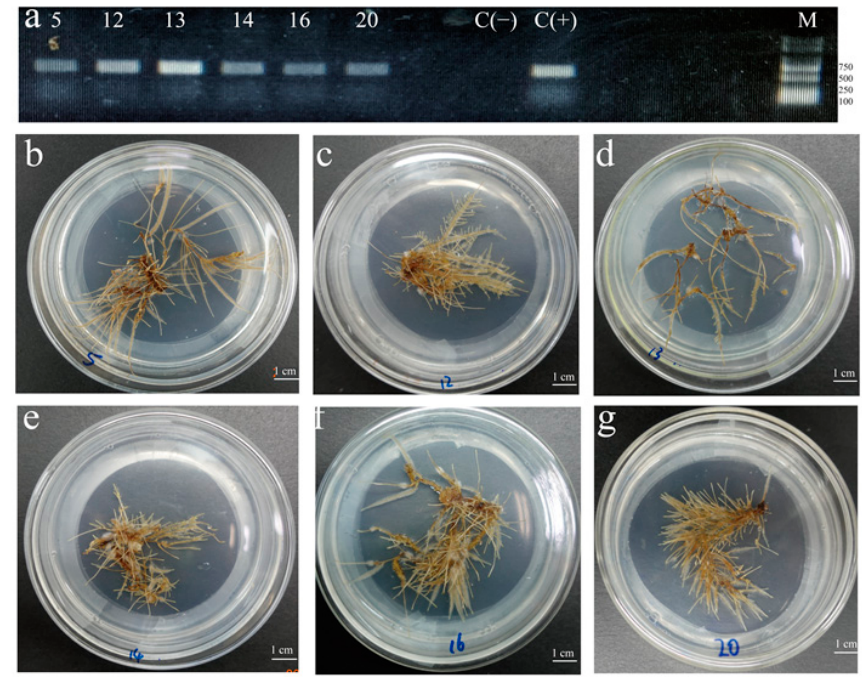
Figure 3. PCR analysis and phenotypes of 6 T. hemsleyanum hairy root lines. ( a ) PCR analysis of the Rol B gene in the hairy root line of T. hemsleyanum [lane M, marker; L1–L6, the hairy roots lines induced by A. rhizogenes Ar Qual, named HR4, 5, 12, 13, 14, 16, and 20; C (+), plasmid DNA from A. rhizogenes Ar Qual (positive control); C ( − ), roots from a non-transformed control plant (negative control)]. ( b ) HR5, ( c ) HR12, ( d ) HR13, ( e ) HR14, ( f ) HR16, and ( g ) HR20. A regression calculation of total fl avonoids concentration by absorbance was carried out, and the following linear equation was obtained—A = 9.6714C + 0.0251 R 2 = 0.999, in- dicating that the mass concentration had a good linear relationship with the absorbance value in the range of 0–0.5 mg/mL. Among the di ff erent samples, HR13 was the highest fl avonoids content (8278.27 ± 698.10 µg/g DW) and HR20 was the lowest fl avonoids con- tent (3453.05 ± 656.99 µg/g DW) (Figure 4b). The standard curves of each standard substance, as determined by HPLC, were as follows (Table 5). According to R 2 , the standard curve has a good linear relationship in the range of the mass concentration of standard substance from 40.00 µg/mL to 240.00 µg/mL, from 0.30 µg/mL to 24.00 µg/mL, or from 1.23 µg/mL to 66.67 µg/mL. The limit of detec- tion (LOD) and limit of quantitation (LOQ) were from 0.150 µg/mL to 0.025 µg/mL and from 0.300 µg/mL to 0.060 µg/mL, respectively, which could meet the needs of the quan- titative detection of each target. Table 5. Standard curves, LOD, and LOQ were established by HPLC. NO.